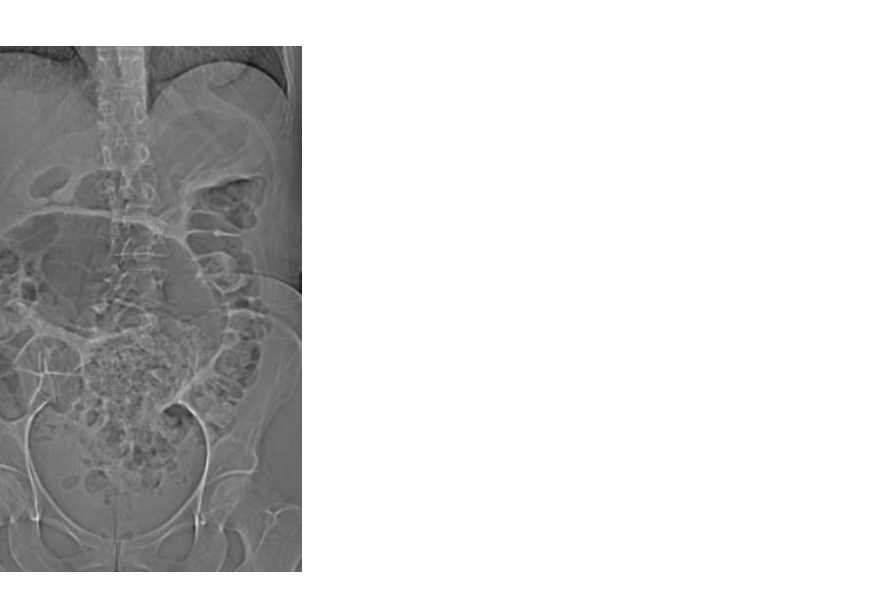
Figure 3. CT topogram demonstrating classical features of a caecal volvulus.